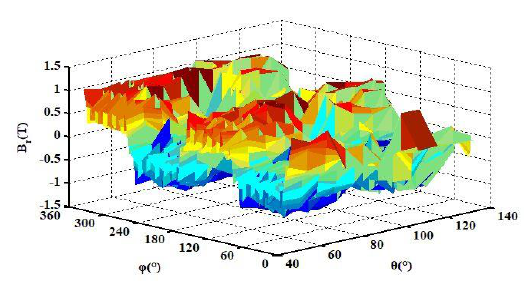
Figure 7. Three-dimensional distribution plot of B r obtained through the finite element analysis.